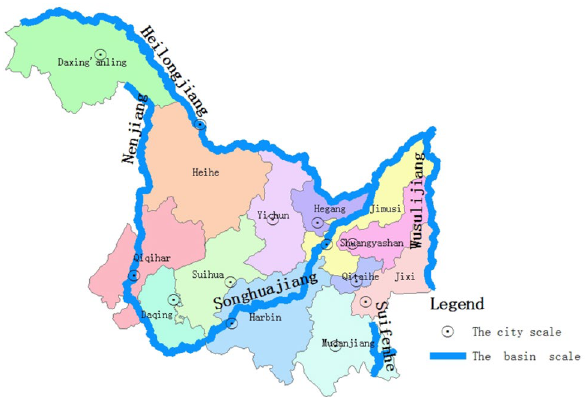
Fig. 1 Study area